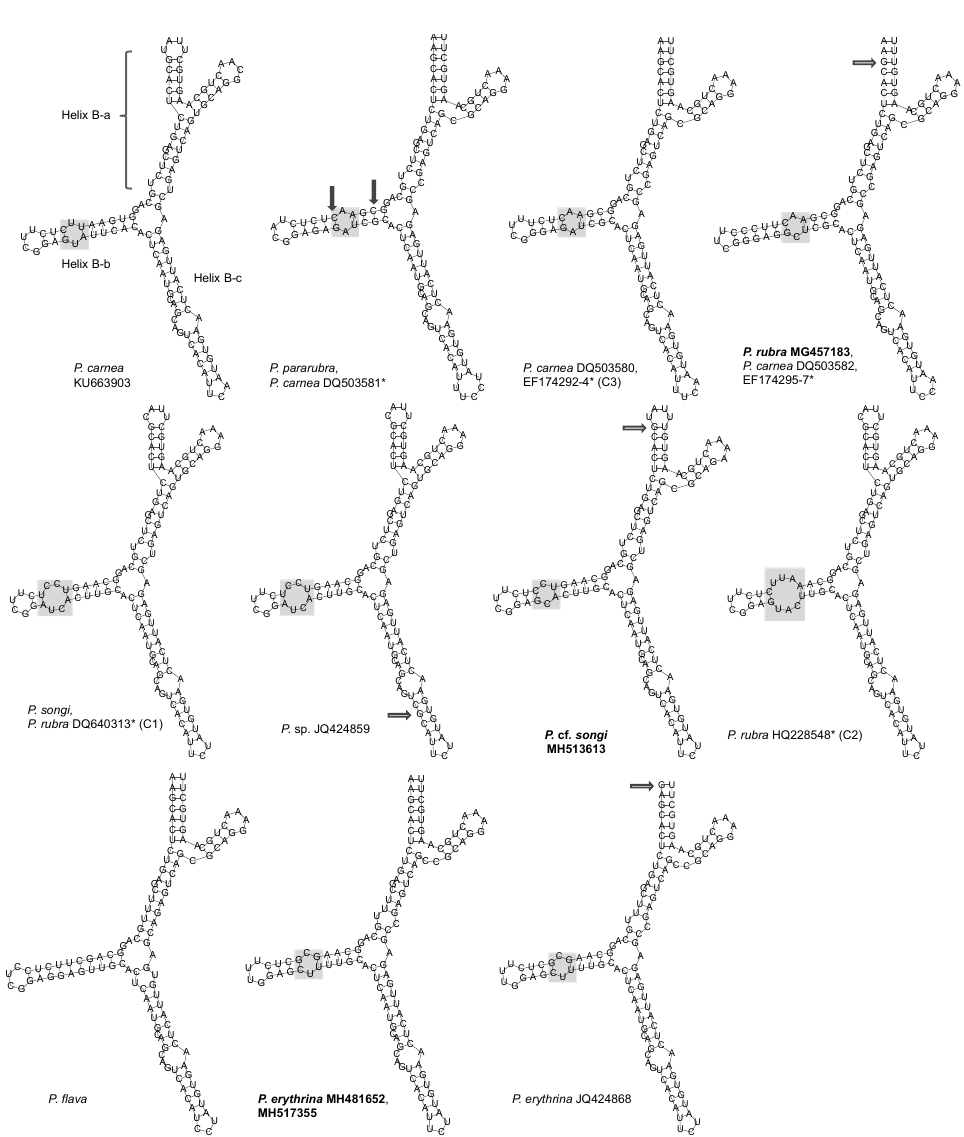
structure of P. carnea as a reference, compensating base changes (CBCs) are marked with filled arrows and hemi-CBCs are indicated with hollow arrows. The variable region is marked by a grey box. Newly sequenced species are in bold. *, misidentified.